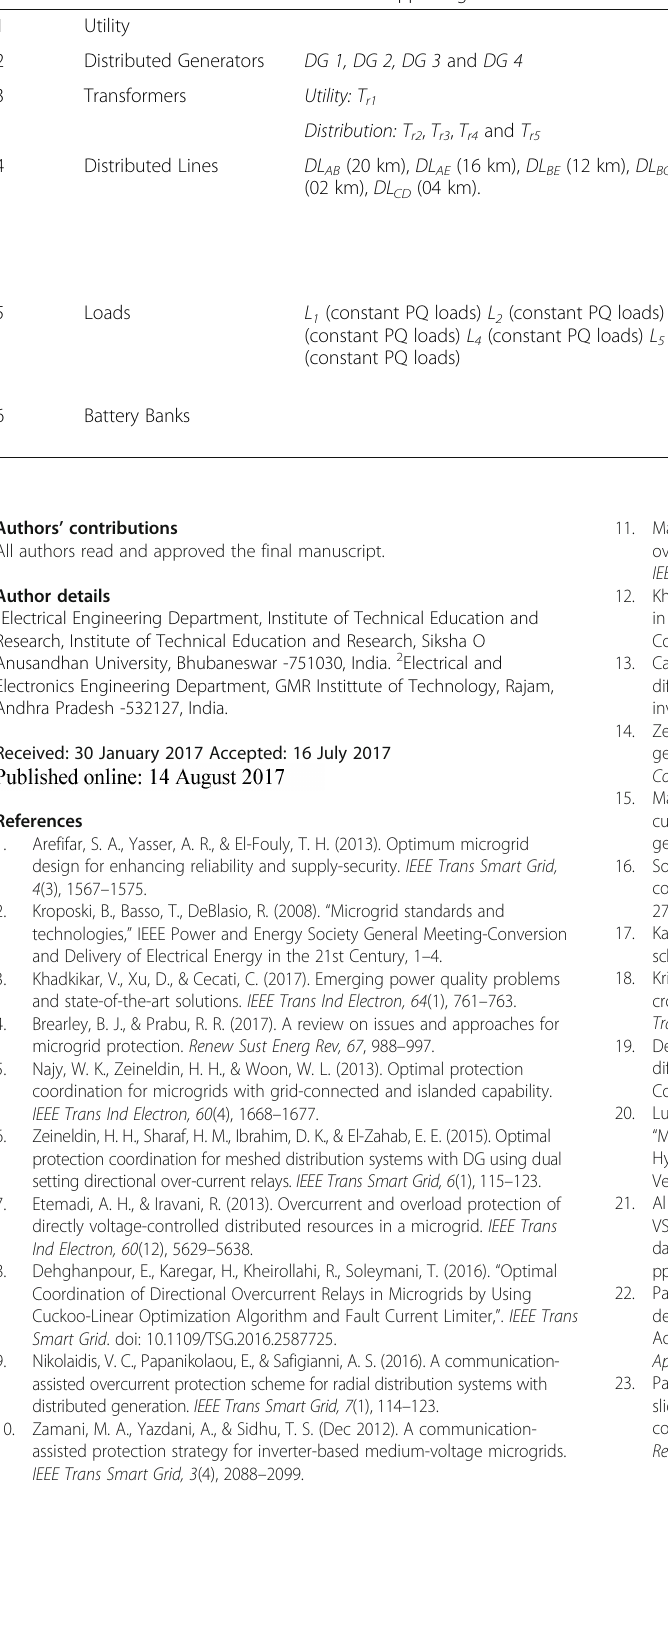
Table 9 The detailed parametric values of the network (Fig. 2) Sl.